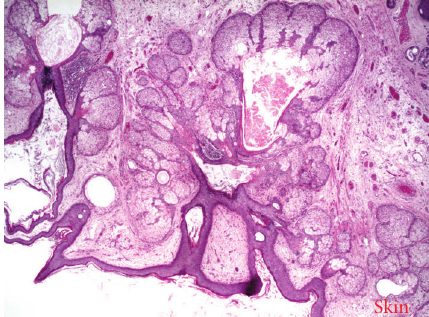
Figure 3: Skin adnexa in teratoma.